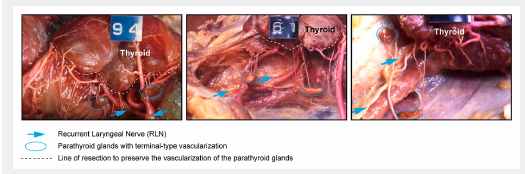
terminal-type vascularisation, and the recurrent laryngeal nerve. Adapted from Delattre JF, Variations in the parathyroid glands. Number, situation and arterial vascularisation. Anatomical study and surgical application J Chir (Paris).